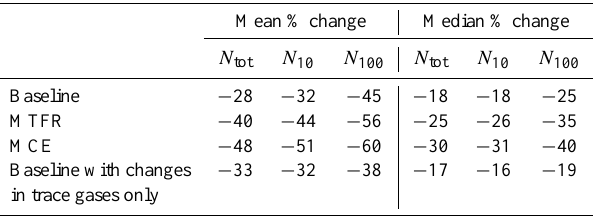
Table 2. Arithmetic mean and median percentage change in particle number concentration over the whole model domain between 2008 and 2030 for the different